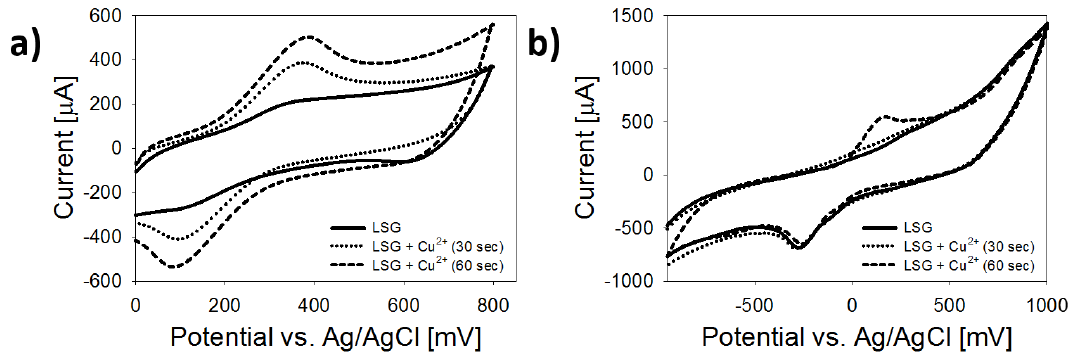
Figure 5. Representative CV at 100 mV/s for LSG electrodes after different Cu 2+ electrodepositions using CuSO 4 and locally sourced copper. ( a ) CV for LSG after metallization with CuSO 4 ; ( b ) CV for LSG after metallization with locally sourced